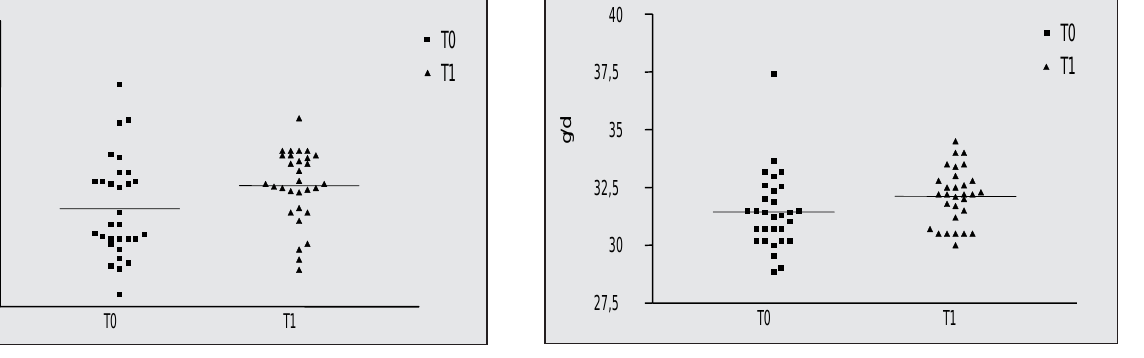
Figura 6 – Distribuição dos valores de CHCM das pacientes antes (T0) e após (T1) a reposição hormonal. Observa-se aumento significativo ( p < 0,05) da concentração de hemoglobina corpuscular média após o tratamento. A barra horizontal representa a média